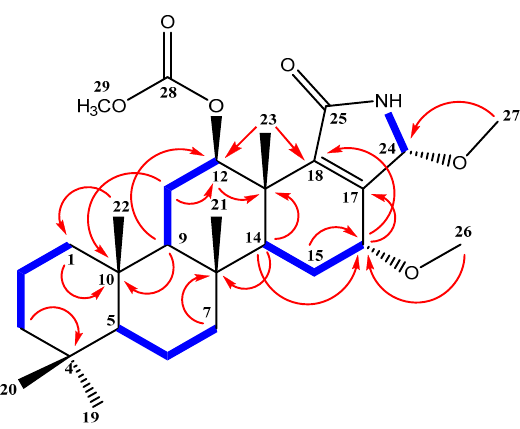
Figure 2. HMBC correlations (arrows) and COSY connectivities (bold bonds) of compound 1 . Table 1. NMR data and HMBC correlations of compound 1 (CDCl 3 ).